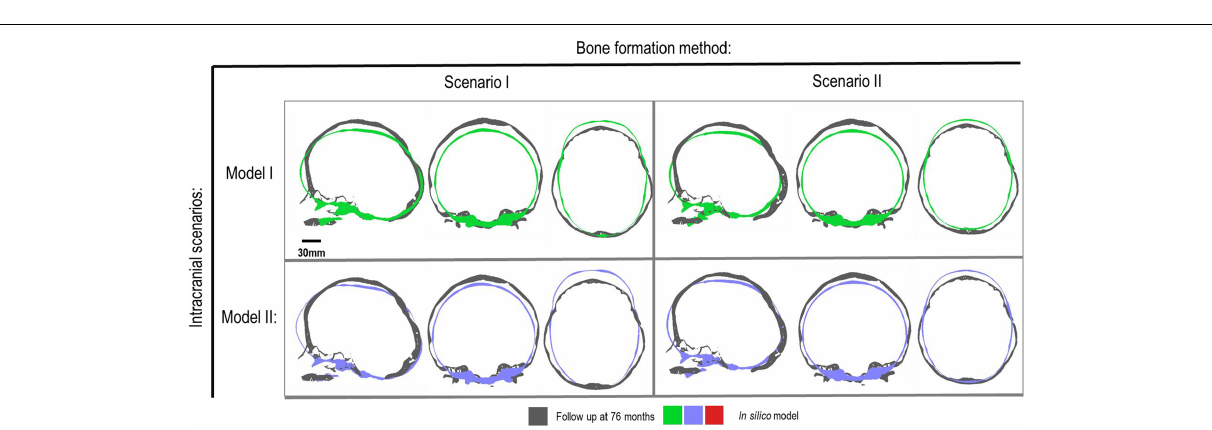
FIGURE 5 | Cross-section analysis of intracranial scenarios (Model I and II) against both bone formation methods (Scenario I and II) at 76 months of age. Showing sagittal, anterior and dorsal